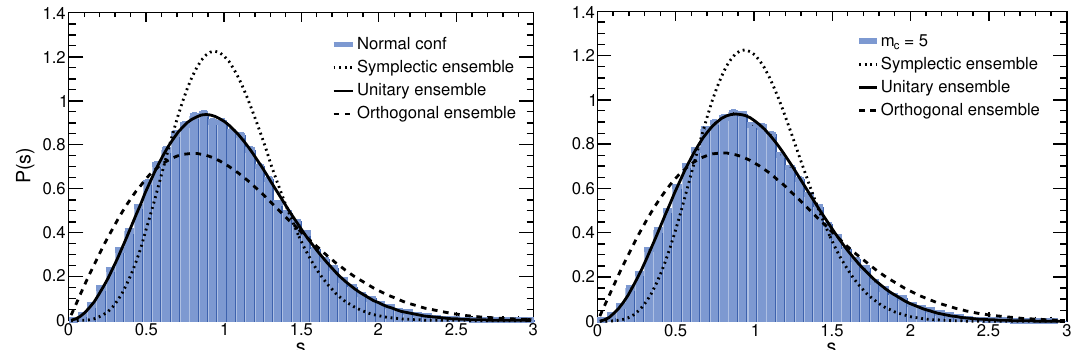
Figure 5 . The distributions P ( s ) of the nearest-neighbor spacing s of the normal con(cid:12)guration (left) and the con(cid:12)guration of m c = 5 (right). The distributions of the GOE, the GUE, and the GSE in the GRMT are represented by the dashed lines, the full lines, and the dotted lines, respectively.